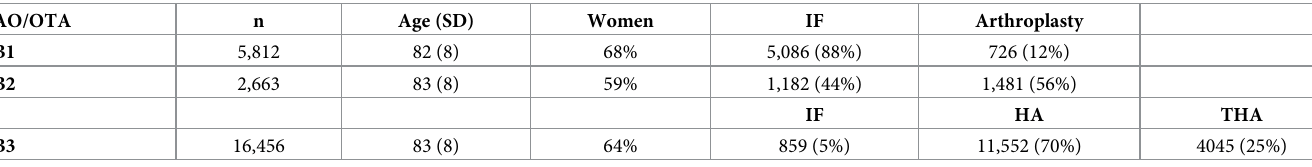
Table 2. Distribution of the 24,931 femoral neck fractures in the study cohort according to the AO/OTA classification. Number of fractures, mean age (SD), sex dis- tribution (% women), treatment n (%) of internal fixation (IF) and arthroplasty for B1 and B2 fractures; IF, hemi arthroplasty (HA) and total hip arthroplasty (THA) for B3